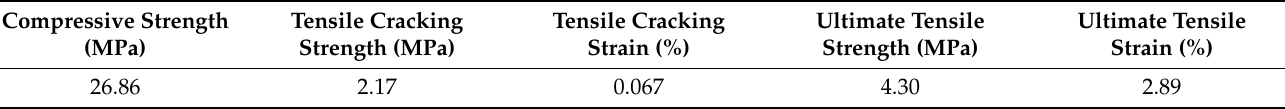
Table 2. Material properties of ECC.